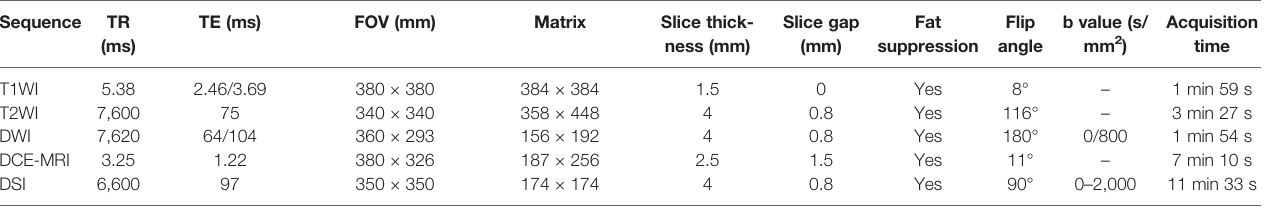
TABLE 1 | Multiparametric MRI sequences and acquisition parameters.